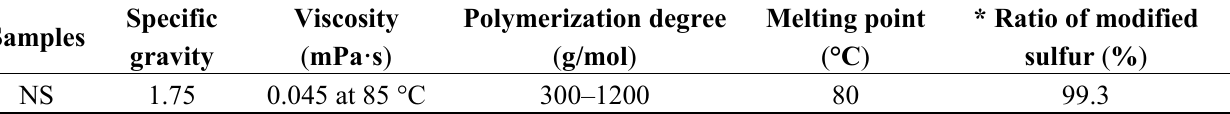
Table 3. Physical properties of modified sulfur.